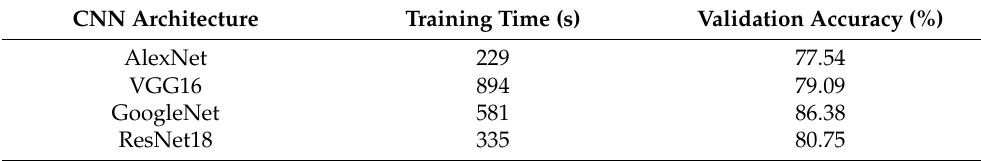
Table 4. Training Progress Result.